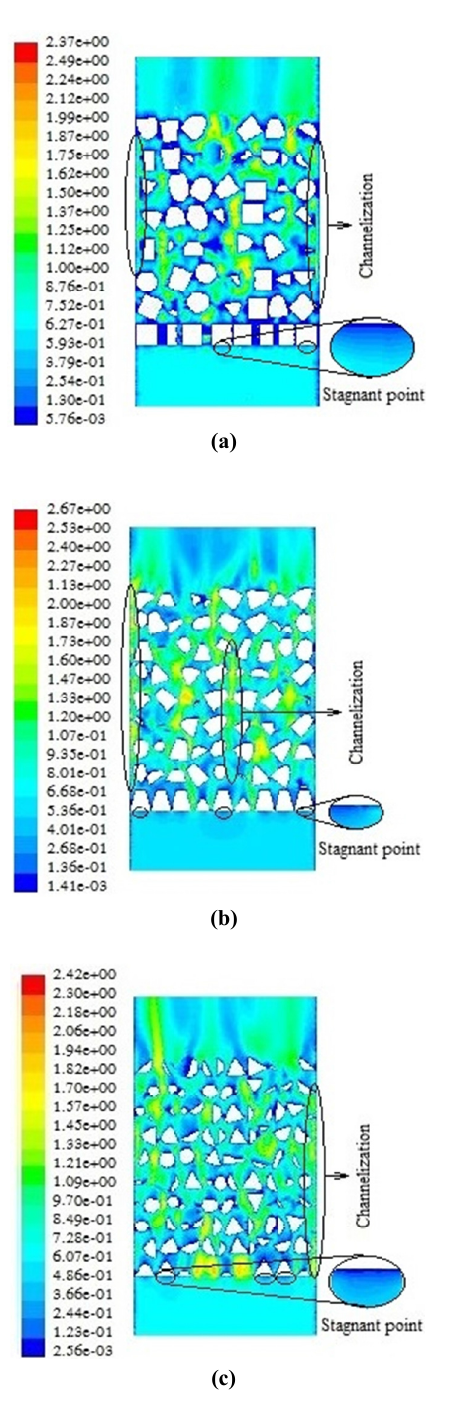
Fig. 3. Velocity contour in the packed beds with V b =94.9 ×10 5 mm 3 and V f = 0.5 m/s: a) cylindrical particles, b) truncated cone particles, and c) cone particles.